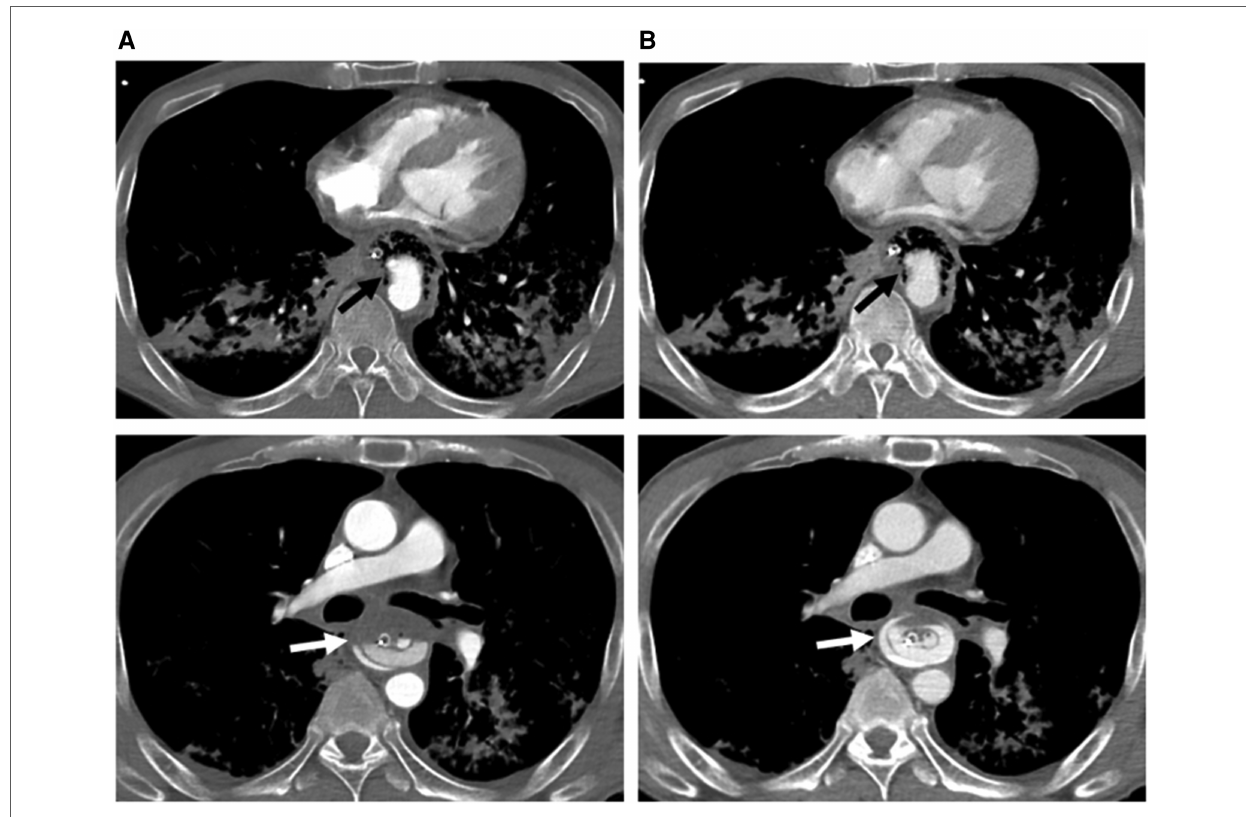
FIGURE 1 Axial computed tomography angiography of arterial ( A ) and venous ( B ) phases at two different levels below the carina, demonstrating a descending aortic pseudoaneurysm (black arrow) protruding into the esophagus (with a nasogastric tube in situ ) through an aortoesophageal fi stula (evidenced by direct communication of esophagus and aorta). There is a progressive increase in amount of contrast material (white arrow) in the esophagus, indicating rupture of the pseudoaneurysm and active